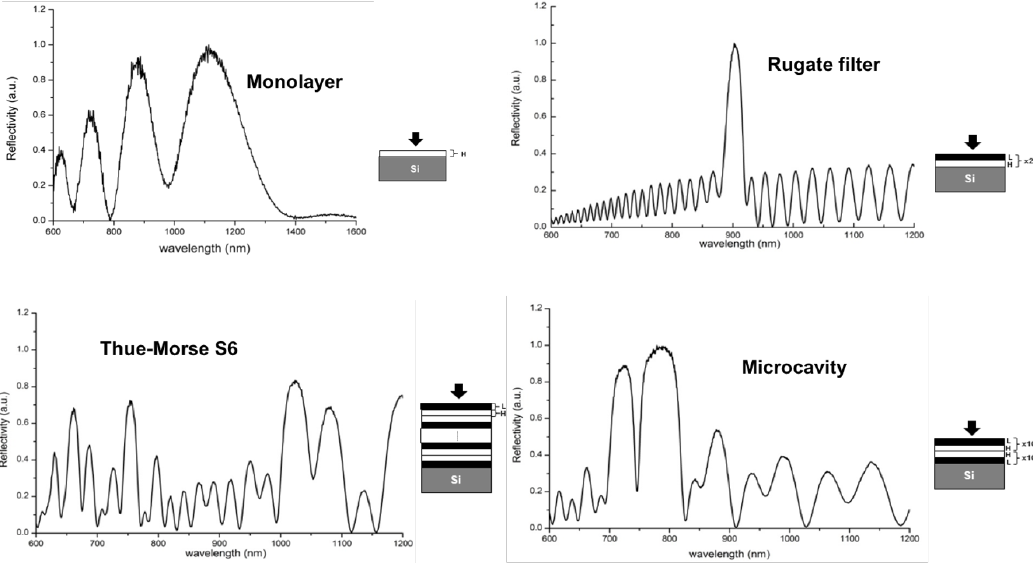
Figure 2. Optical spectra of different PSi optical structures. H stands for the high porosity layer, L for the low porosity layer. The numbers indicate how many pairs of H-L layers constitute each structure.